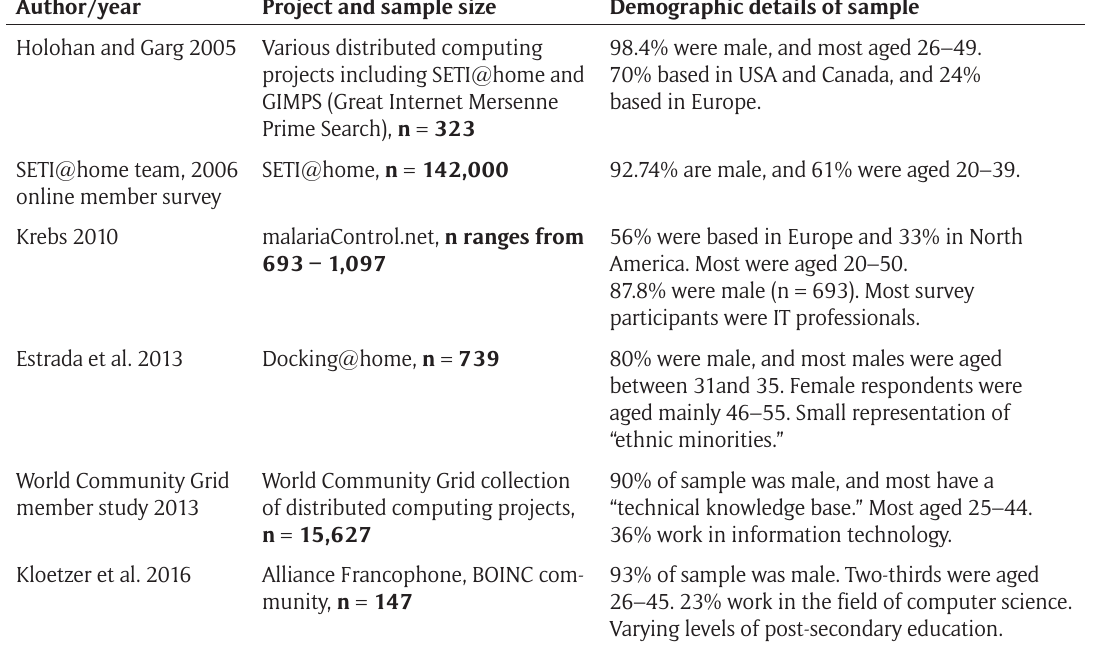
Table 1: Demographic data of citizen scientists involved in DC projects obtained from six published studies or